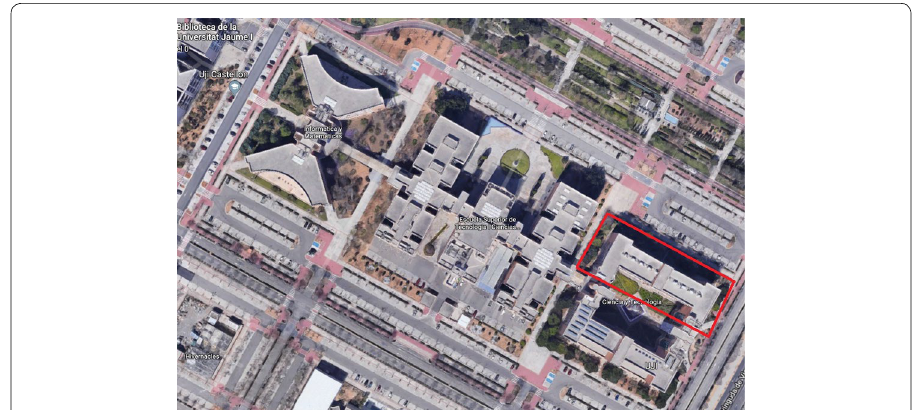
Fig. 13 The location in the Jaume University in which measurements were taken (bounded by a red